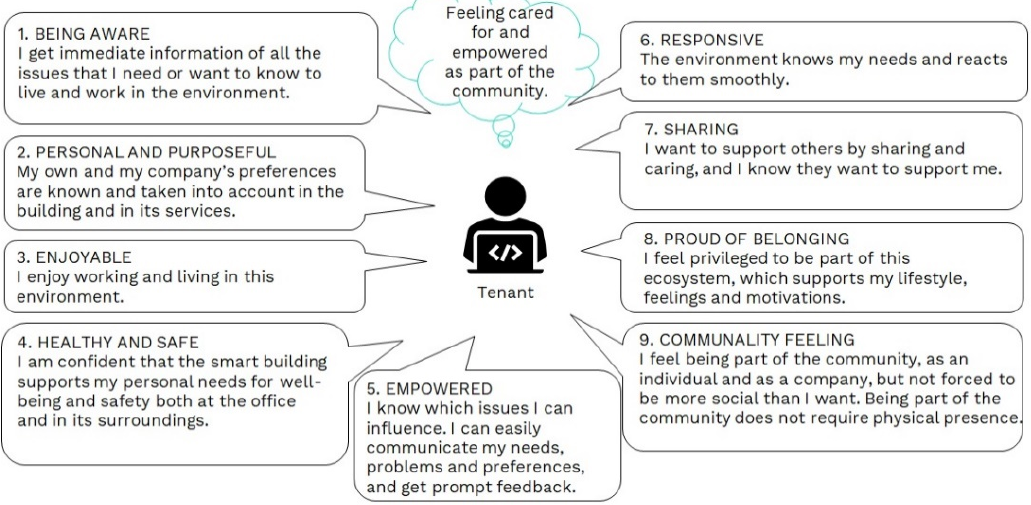
Figure 7. The UX vision and UX goals for tenants.